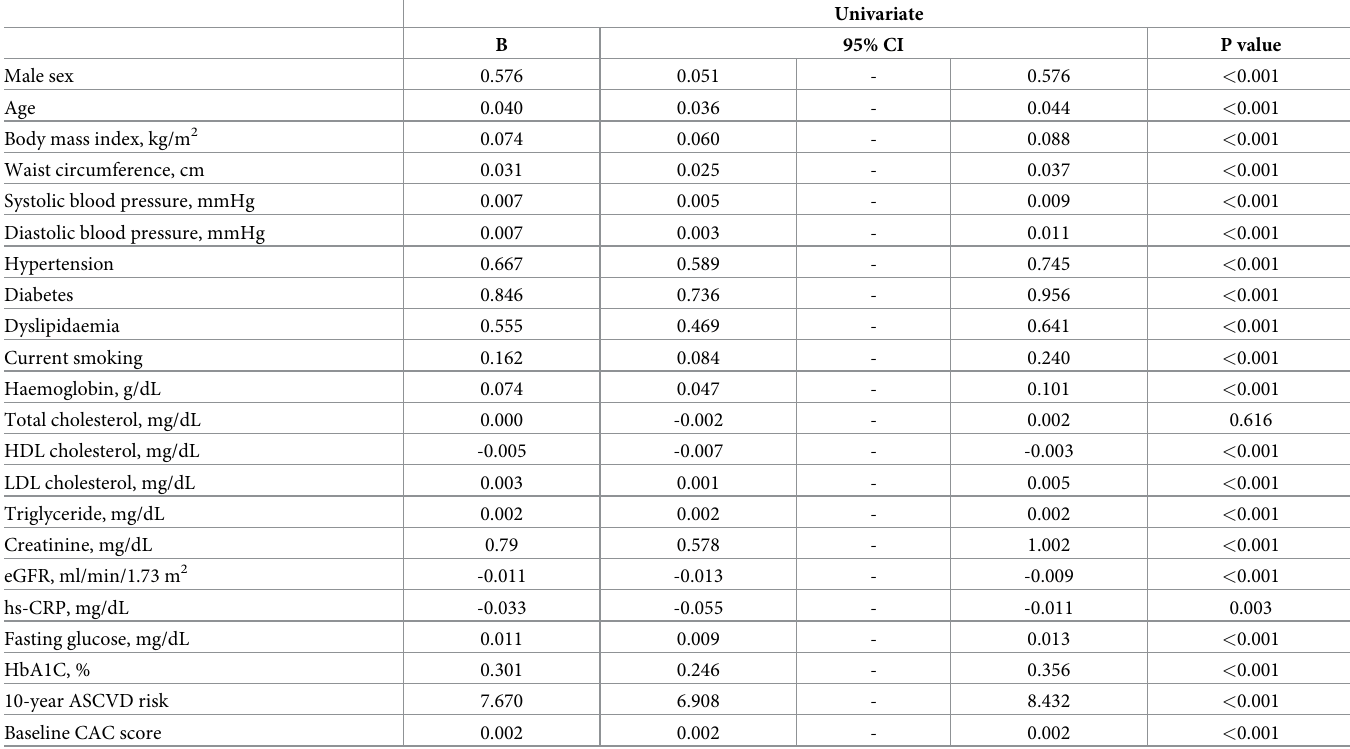
Table 2. Univariate analysis for factors associated with the CAC progression